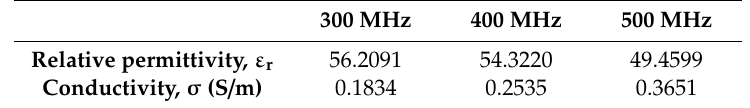
Figure 10. ( A ) The schematic of the front view (a transversal slice in the middle of the phantom) of the rectangular agarose phantom. The cross marks indicate the positions of fiber optic temperature sensors. ( B ) Front view of the rectangular agarose phantom: the yellow wires are fiber optic temperature sensors which were placed into the center of the phantom; the four blue tubes were filled with vegetable oil used as references for MR thermometry; the two antennae were installed opposing each other at two sides of the phantom. ( C ) The schematic of the lateral view of the phantom. ( D ) Lateral view of the phantom that shows one of the SGBT antennae. The printed circuit board on the antenna block is a balanced to unbalanced (balun) transformer for matching a 50 Ohm coaxial cable to the antenna port and vice-versa. A microstrip exponential taper was used to combine the balun with impedance matching. Table 3. Dielectric properties of the phantom at frequencies of 300 MHz, 400 MHz and 500